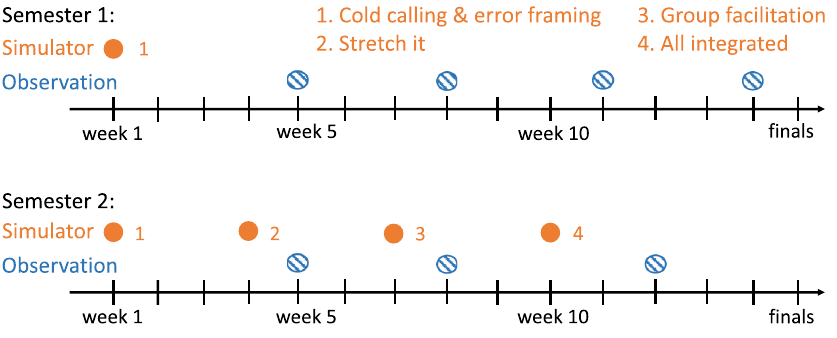
FIG. 3. Timelines of the simulator training and classroom observations in semester 1 and semester